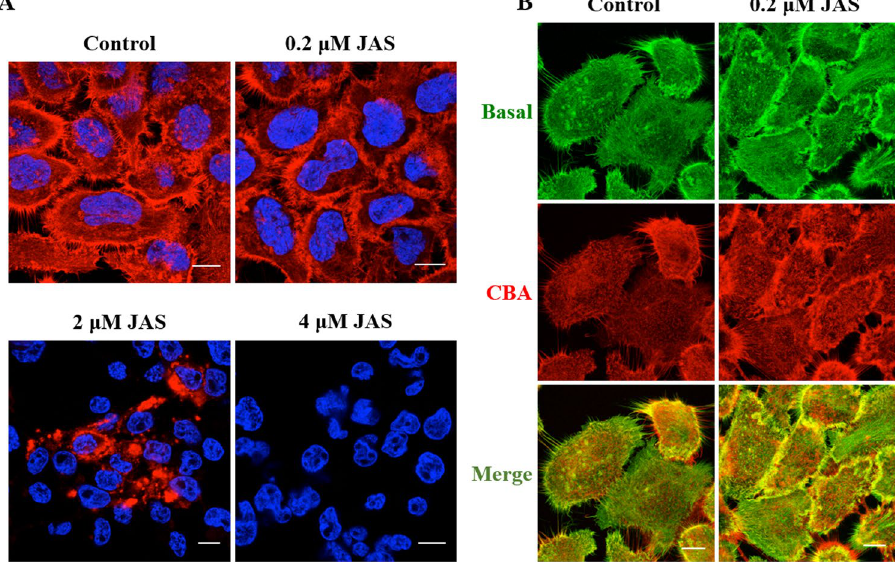
Figure 5. Effects of JAS on the actin architecture in A431 cells. Cells on coverslips were treated either with diluent control (0.1% DMSO) or 0.2, 2.0 or 4.0 μ M JAS for 45 min before fixing and staining with Rh-P and Hoechst. ( A ) Single sections show the overall distribution of the actin relative to the nucleus. ( B ) Actin arrangement from the basal, CBA regions and composite (Merge) of basal and CBA. Scale bars 10 μ